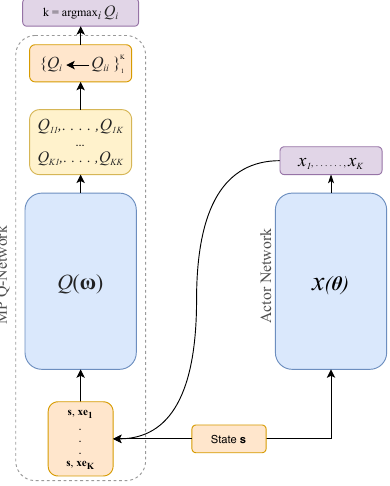
Figure 1. Structure of MP-DQN architecture.